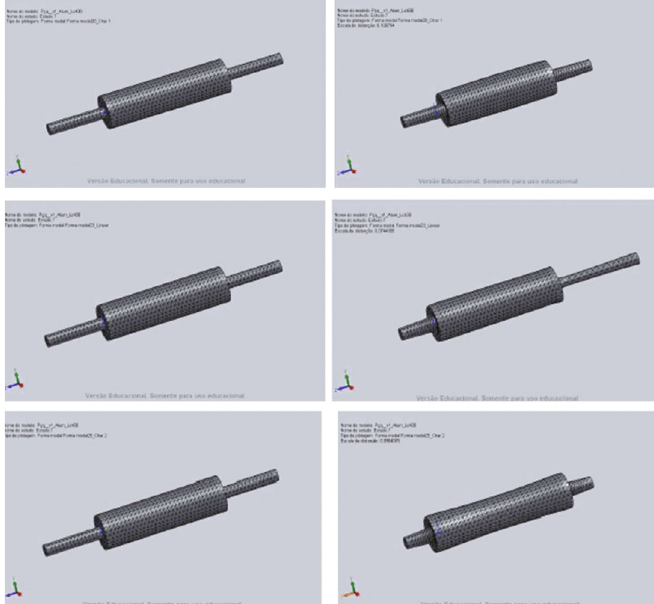
Figure 6: Vibration modes of the broadband detector. The mode on the top all three bars vibrate at the same phase, frequency: 4772 Hz; the mode in the middle the central bar does not vibrate but it oscillates and the side bars vibrate in counter phase, frequency: 5961 Hz; the mode on the bottom the side bars vibrate in counter phase to the central bar, frequency: 7170Hz. Central bar length equal to 0.63m and sidebar length equal to 0.3m. Source: from authors